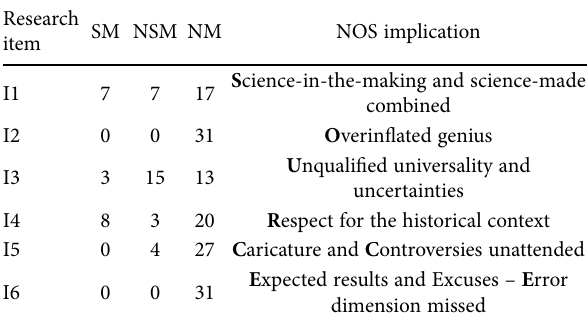
Table 7. SOURCE approach applied to Norwegian and Spanish textbook analysis. SM, satisfactory mention; NSM, non-satisfactory mention; NM, no